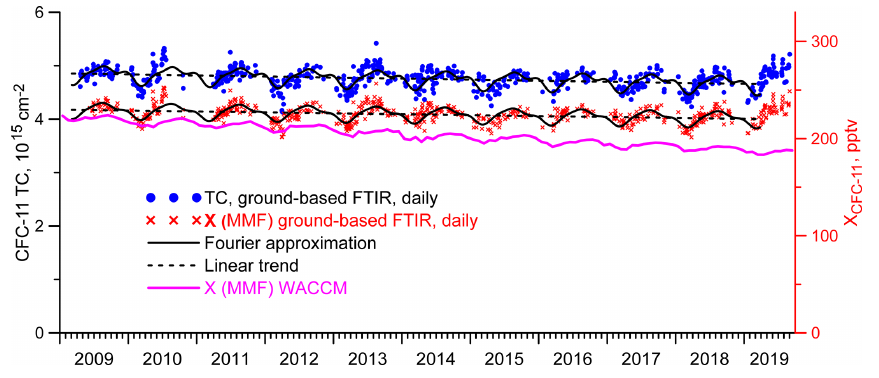
Figure 4. Daily mean TCs and Xgas of CFC-11. The T − Ph parameter α = 85.